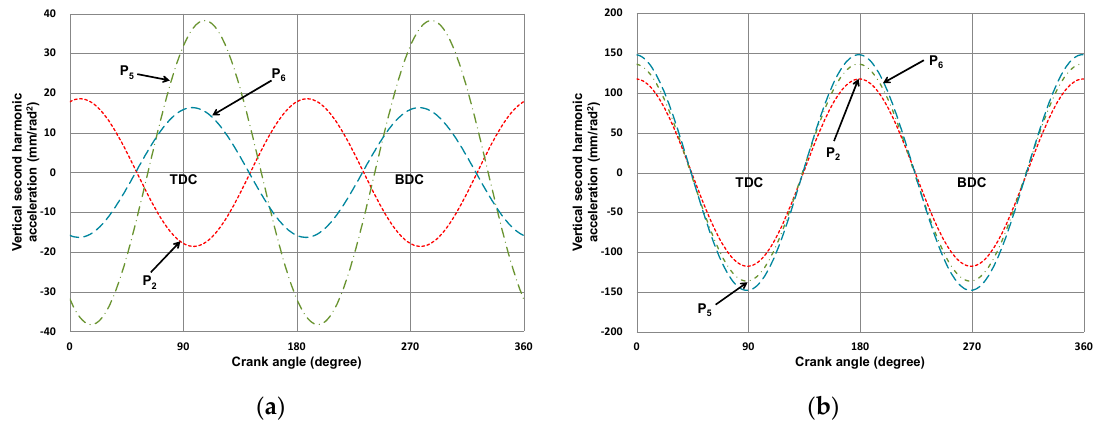
Figure 6. Vertical second harmonic acceleration at each joint in candidate mechanisms in the in-line four-cylinder engine: ( a ) initially designed Stephenson III and ( b ) initially designed Watt II.